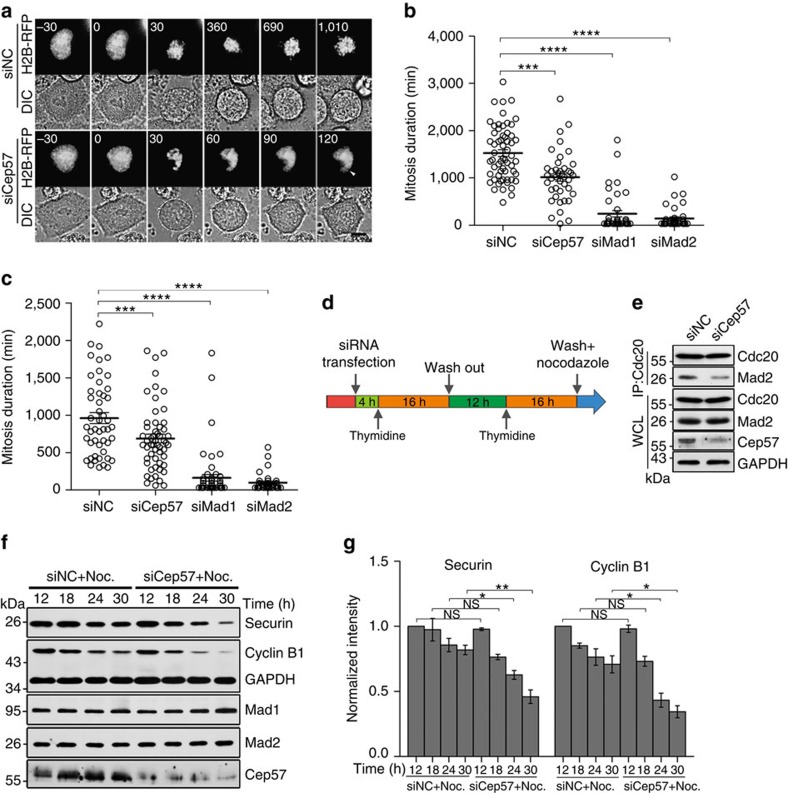
Cep57 contributes to activation of the spindle assembly checkpoint.(a,b) HeLa cells with 100 nM nocodazole treatment after co-transfection with H2B-RFP and negative control (NC)-, Cep57-, Mad1- or Mad2-siRNA for 48 h. (a) Time-lapse images of HeLa cells. The numbers indicate the time (minutes) after entry into mitosis. Arrowhead, multiple nuclei. Scale bar, 5 μm. (b) Quantification of mitotic duration of HeLa cells from a. Scatter plots show data from three independent experiments. (c) Quantification of mitotic duration of live HeLa cells with 80 nM taxol treatment after co-transfection with H2B-RFP and negative control (NC)-, Cep57-, Mad1- or Mad2-siRNA for 48 h. Scatter plots show data from three independent experiments. (d) Diagram of experimental design. The siRNA-transfected HeLa cells were synchronized by double-thymidine block, and released into nocodazole. (e–g) HeLa cells were treated as in d. (e) After 12 h nocodazole treatment, mitotic cell lysates were used to perform immunoprecipitation (IP) and western blotting assays with the indicated antibodies. WCL, whole-cell lysate. (f) Western blots of the indicated proteins in HeLa cells after the indicated nocodazole (Noc.) treatment time. (g) Quantification of the protein levels of securin and cyclin B1 from (f). The experiment was repeated three times. For b,c and g, data are mean±s.e.m. ****P<0.0001; ***P<0.001; **P<0.01; *P<0.05; NS, not significant (unpaired two-tailed Student's t-test). DIC, differential interference contrast.